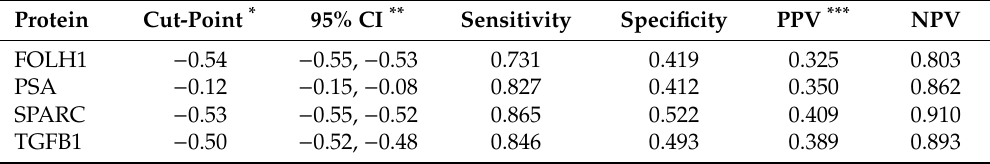
Table 3. Cut-point identification for distant metastasis (DM) by protein marker.